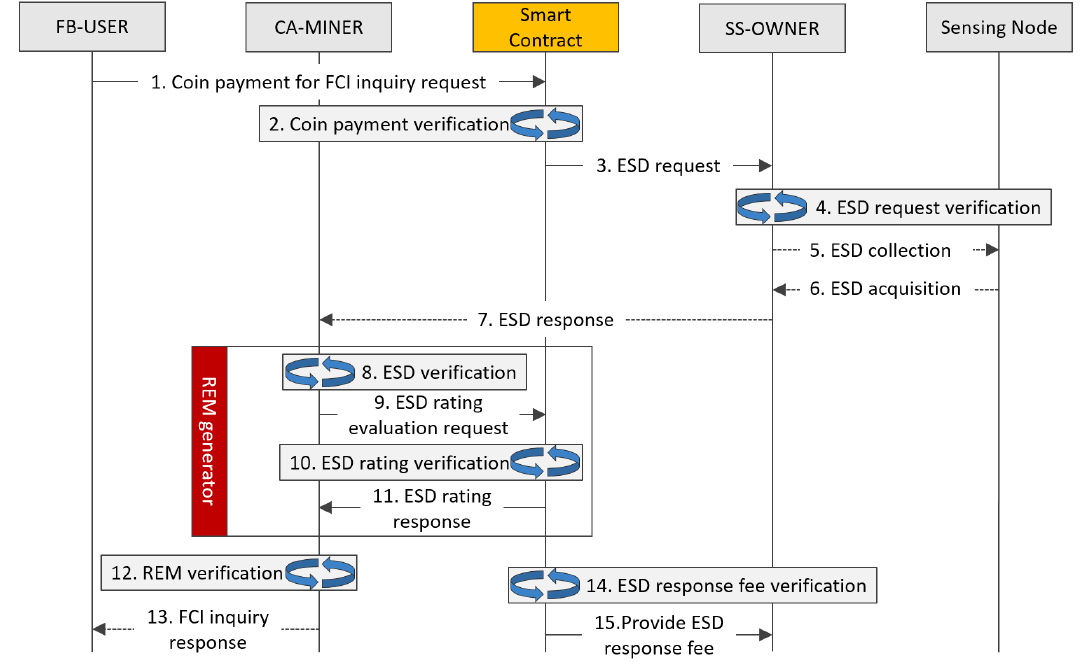
Figure 2. Overall operation process between entities composing the